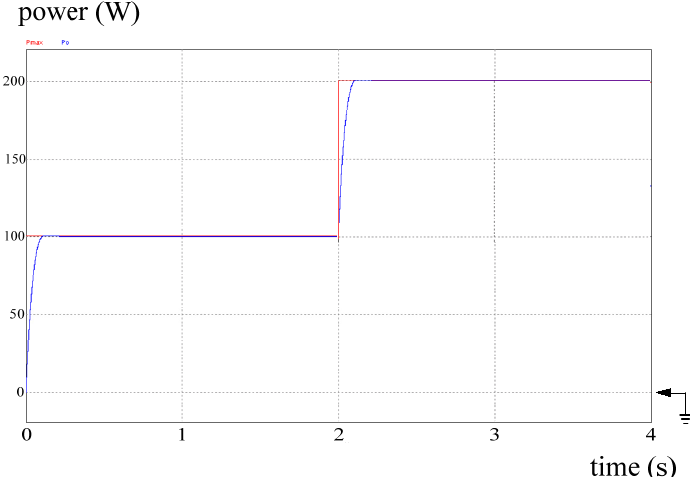
Figure 19. Simulated result: tracking trajectory of the converter with the DLAA while PV power steps up from 100 to 200 W. Note: power: 50 W/div; time: 1